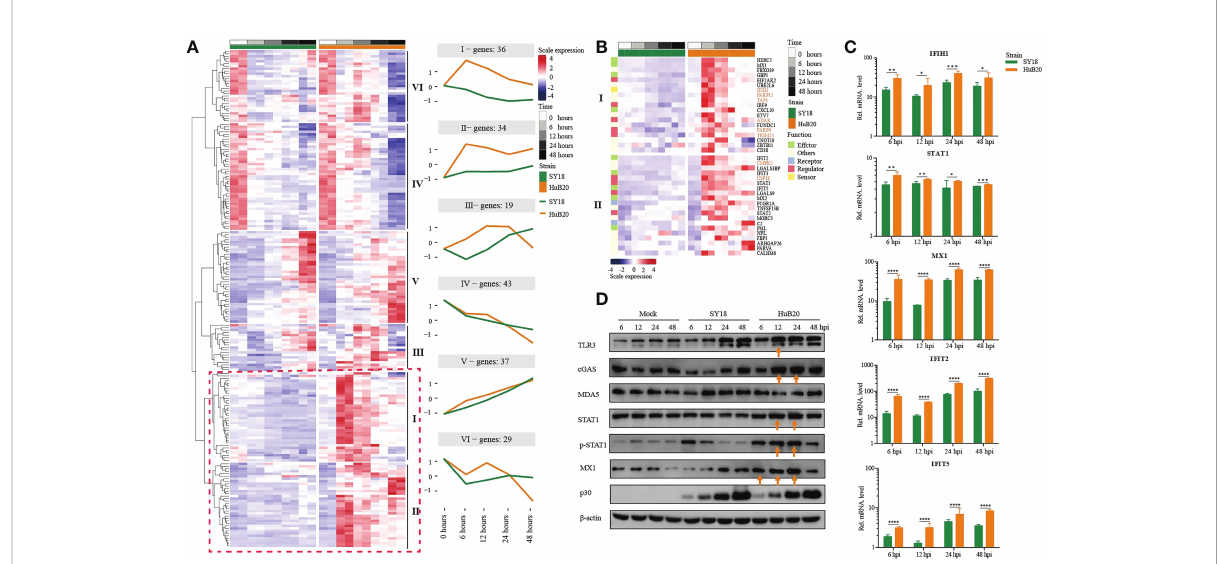
FIGURE 6 Comparison of host gene expression differences. (A) Heatmap of DEGs considering the effects of infection of SY18 and HuB20 separately over time on PAMs with the LRT test. The full model ’ s design formula includes the effects of infection over time, and the reduced model removes this term to perform the LRT test. The line plots illustrate the average trend of gene expression in clusters. Each cluster has at least 15 genes. (B) . Heatmap of the DEGs in clusters I and II, with immune related functions annotated for each gene. (C) Validation of innate immunity associated gene expression by real time-PCR. PAMs were infected or mocked infected by ASFV SY18 and HuB20 strains, respectively (MOI= 3), at 6, 12, 24 and 48 hpi. Total RNA was extracted from the PAMs and subjected to RT-qPCR to quantitate IFIH1, STAT1, MX1, IFIT2 and IFIT5 expression. The data were normalized using b -actin. The fold-difference was measured by the 2 - DD Ct method. Differences were assessed using a two-sample t-test. Signi fi cance was de fi ned at P <0.05 . *, P < 0.05 , **, P < 0.01 ; ***, P < 0.001 , ****, P < 0.0001 . (D) Western blotting analysis of innate immunity associated proteins. PAMs were infected or mocked infected by ASFV SY18 and HuB20, respectively (MOI= 3), at 6, 12, 24 and 48 hpi. Cell lysates were collected and subjected to Western blotting analysis using the indicated